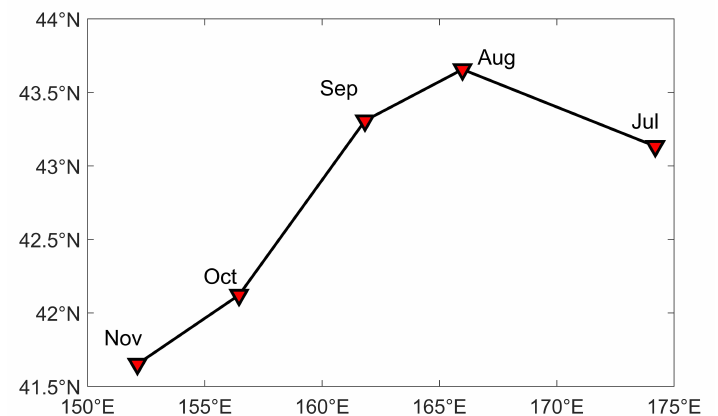
Figure 4. Distribution of gravity center of average monthly fishing effort of squid-jigging vessels in the North Pacific Ocean from July to November during 2017 to 2020.